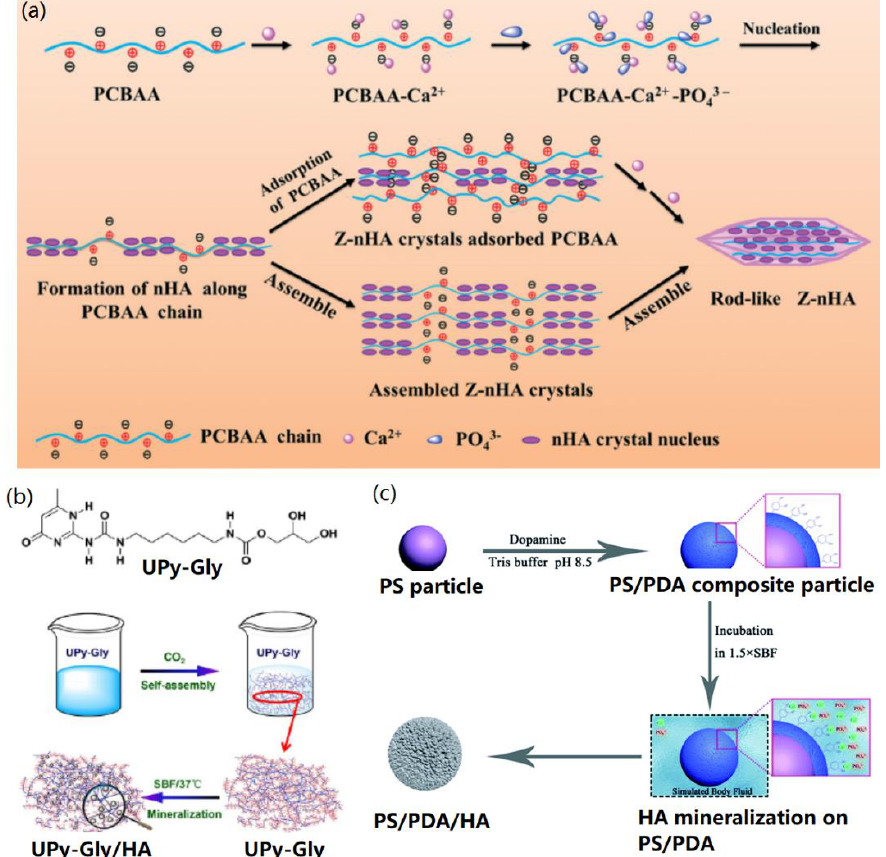
Figure 2. Biomimetic synthesis strategies of HA: ( a ) In-situ biomimetic chemical synthesis of HA in the presence of Ca 2 + and HPO 42 − . Reprinted with the permission from [35]. Copyright 2018 Royal Society of Chemistry. ( b ) HA biomineralization in simulated body fluid (SBF). Reproduced with the permission from [36]. Copyright 2017 American Chemical Society. ( c ) HA biomineralization in 1.5 × SBF. Reproduced with the permission from [37]. Copyright 2016 Royal Society of Chemistry.